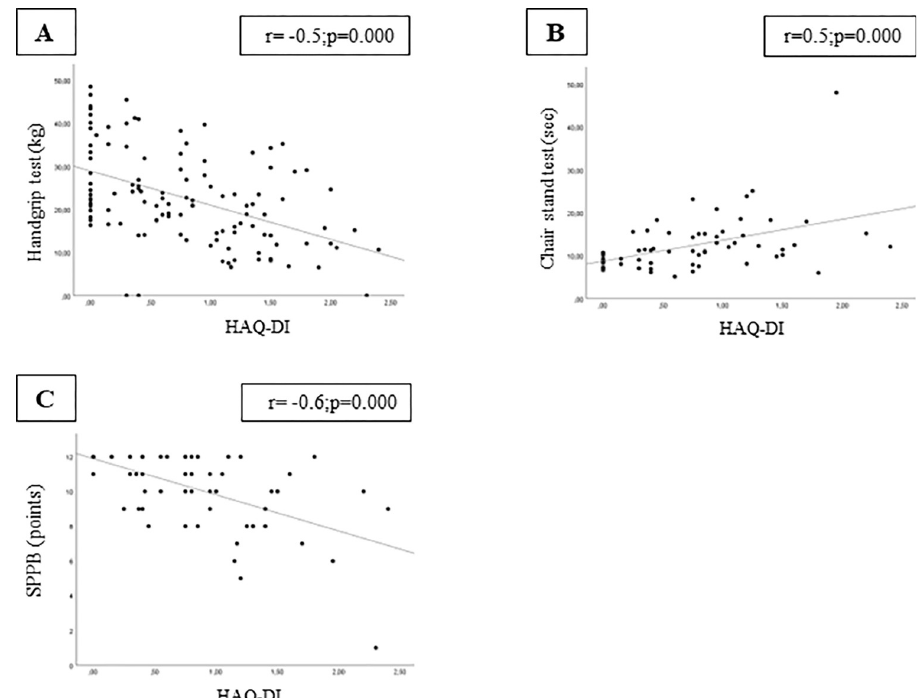
Fig 3. Correlation analysis was significant between HAQ-DI and (A) handgrip test, (B) chair stand test, and (C) SPPB in North American cohort. Abbreviations: SPPB, Short Physical Performance Battery; kg, kilogram; sec, seconds.